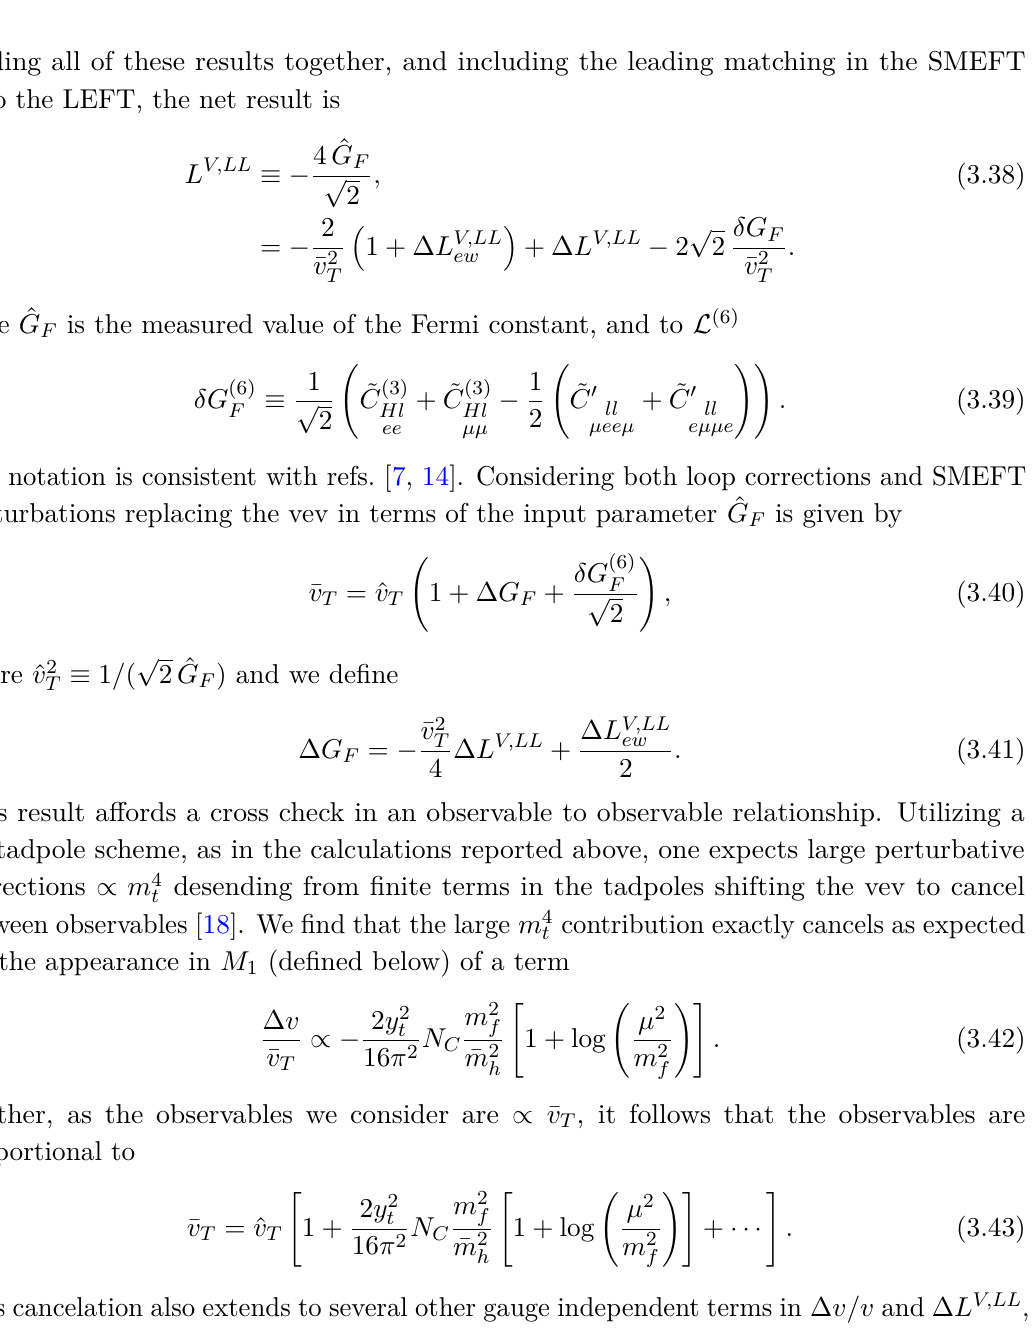
Figure 1 . One loop QED contribution to µ − → e − + ¯ ν e + ν µ